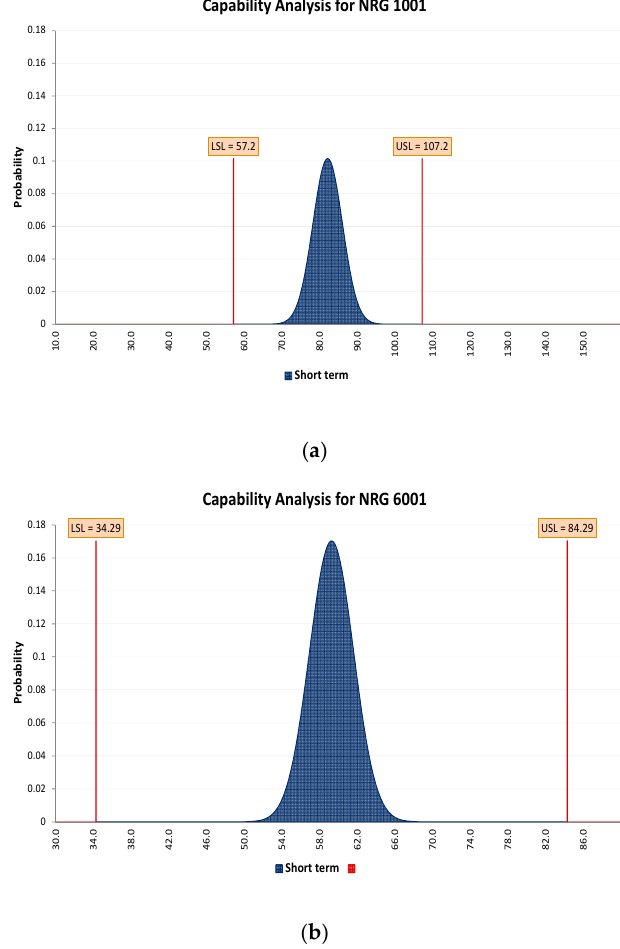
Figure 8. Cpk analysis on single filament diameter of Vestamid NRG fibres. ( a ) Displays the Cpk analysis for NRG 1001 and ( b ) the Cpk analysis for NRG 6001.